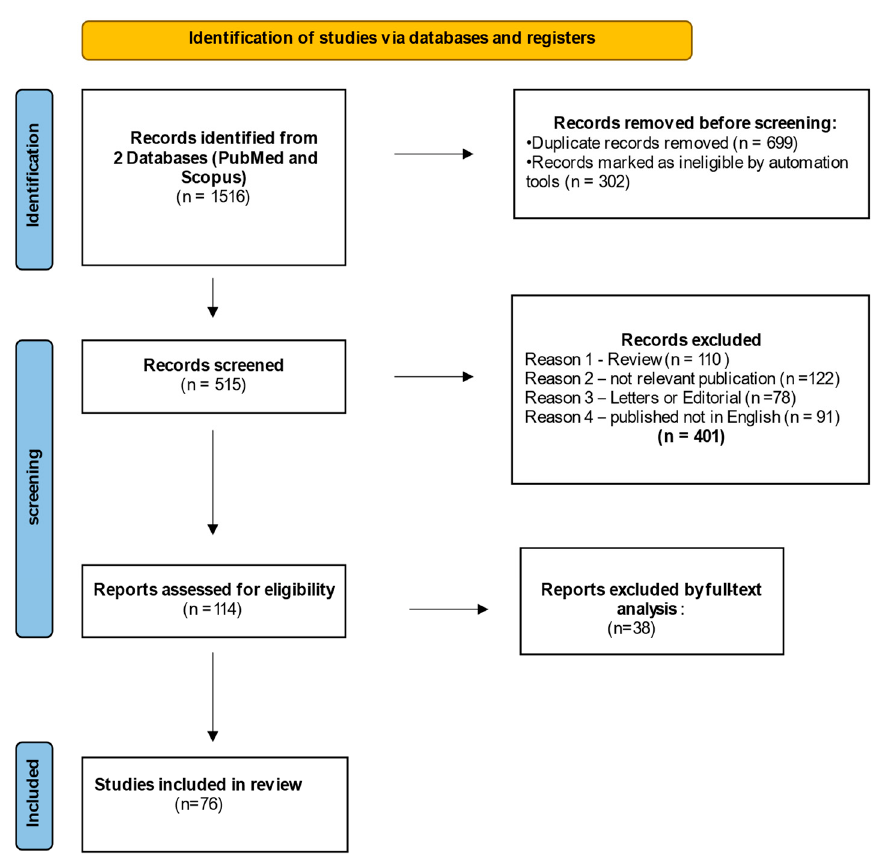
Figure 2. PRISMA fl ow diagram summarizing the literature selection process. Figure 2. PRISMA flow diagram summarizing the literature selection